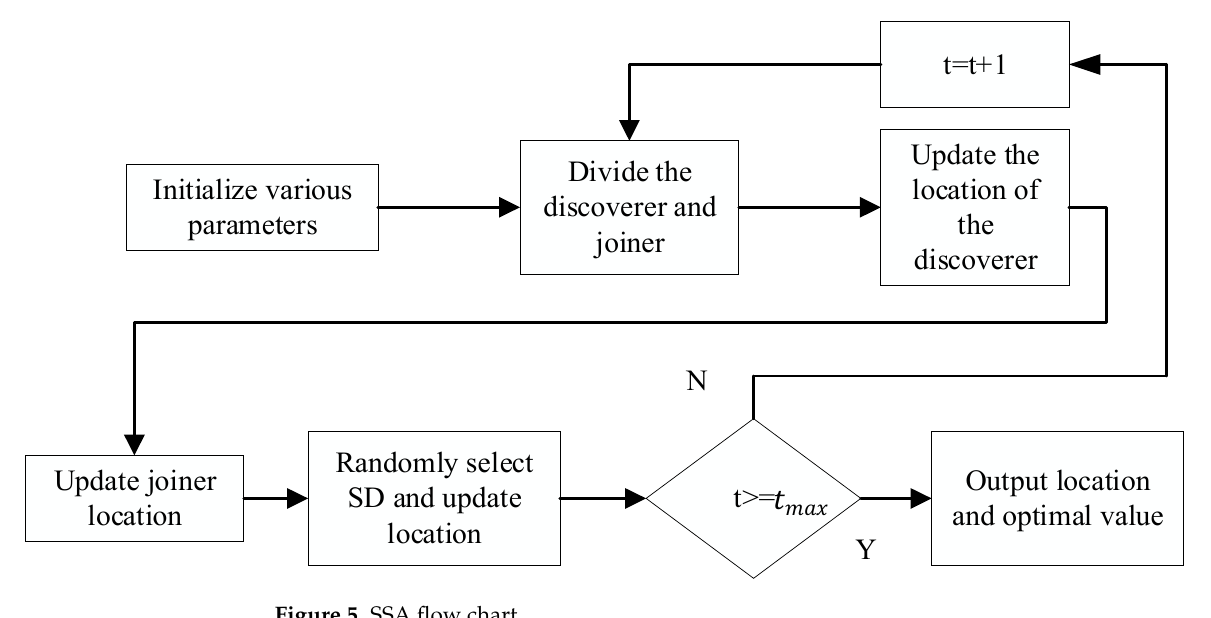
Figure 5. SSA flow chart.